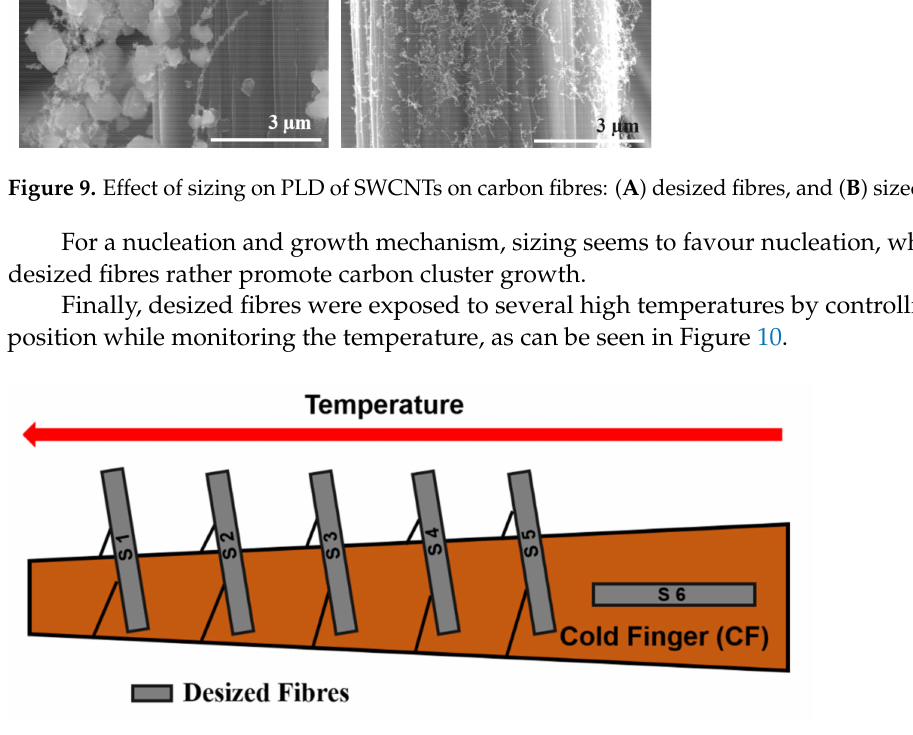
Figure 10. Schematics of the sample’s positions on the Cold Finger for deposition at various